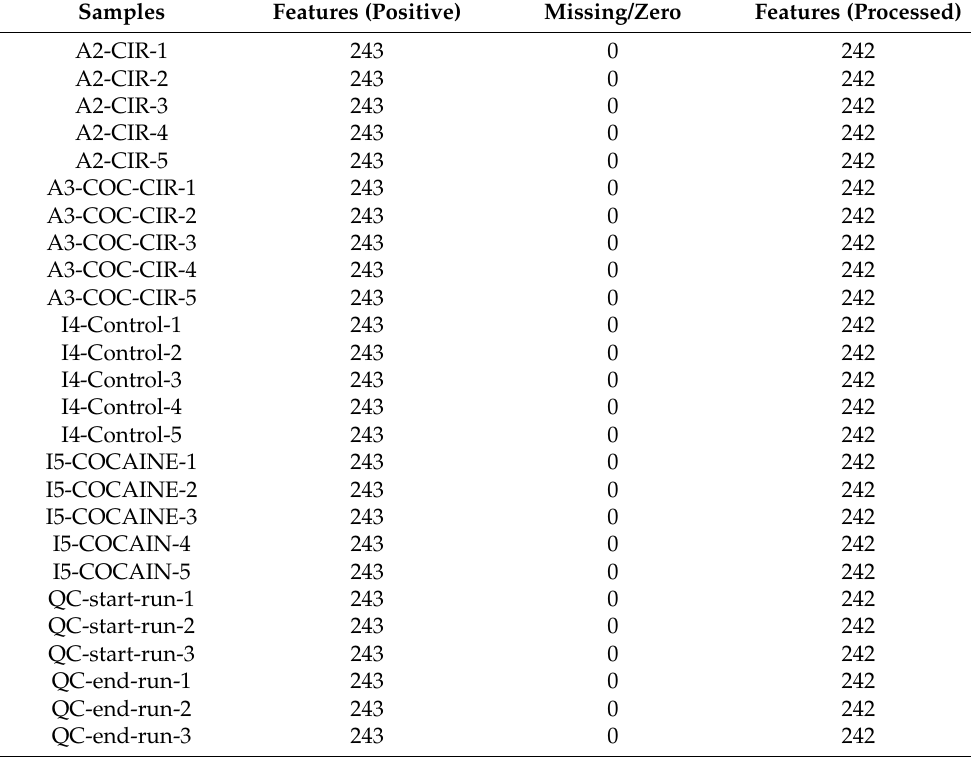
Figure 1. Workflow of the metabolomic data analysis of the plasma samples. ( A – C ) Schematic representation of the untargeted metabolome data workflow regarding quantification, annotation, and identification of metabolites in the control, circadian disruption (CRSD), cocaine, and CRSD with cocaine treatment groups. ( D ) Metabolite data analysis before and after normalization. Table 1. Summary of data processing results for all